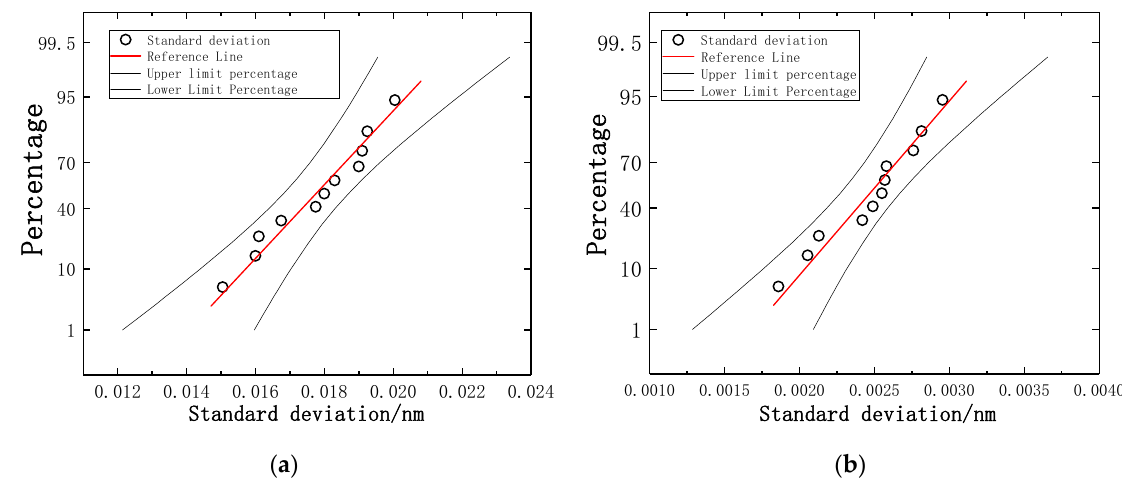
Figure 18. Probability distribution of standard deviation: ( a ) Probability distribution of torque; ( b )